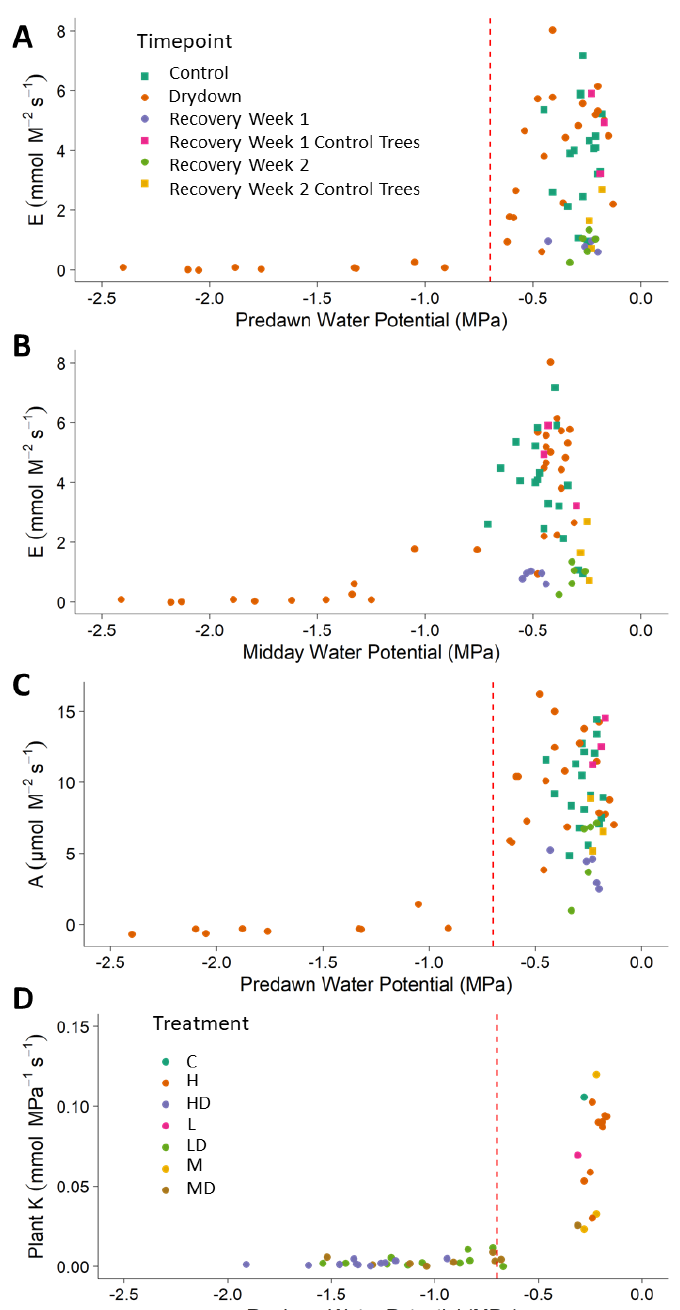
Figure 4. Plant physiological parameters measured throughout the experiment. ( A ) Interaction of predawn water potential (MPa) and leaf level transpiration (E, mmol m − 2 s − 1 ). ( B ) Interaction of midday water potential (MPa) and leaf level transpiration (E, mmol M − 2 s − 1 ). ( C ) Interaction of predawn water potential (MPa) and leaf level carbon assimilation (A, µ mol m − 2 s − 1 ). For panels ( A – C ), Control trees are squares, while dry down and dry drown recovery trees are circles. ( D ) Inter- action of predawn water potential (MPa) and whole plant conductance (K, mmol MPa − 1 s − 1 ) of trees the day before burn. For panel D, each point color is a different burn treatment, acronyms are control (C), low fuel loading (L), low fuel loading + drought (LD), medium fuel loading (M), medium fuel loading + drought (MD), high fuel loading (H), high fuel loading + drought (HD). Vertical dashed red line is the point at which mid-day leaf level transpiration had stopped during the post burn dry down curve ( − 0.7